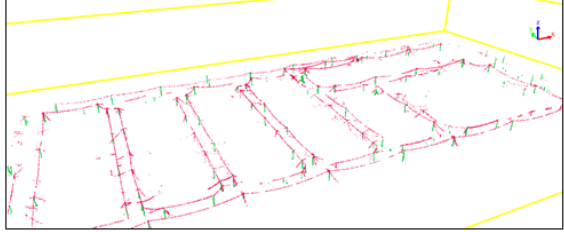
Figure 5 . The pole and powerline detected using the Machine Learning